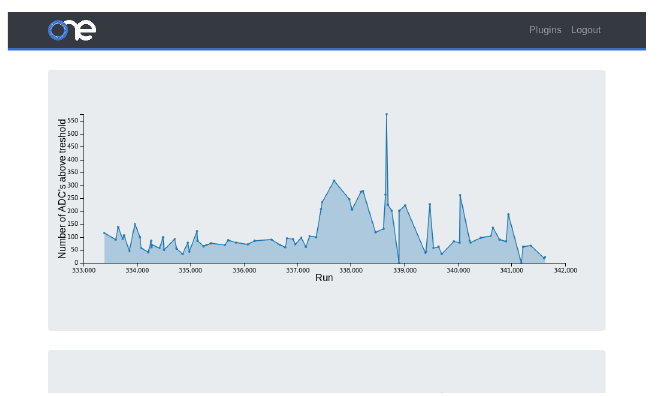
Figure 6. Screenshot of the Simple Static Plugin Template for new Tile-in-One platform.